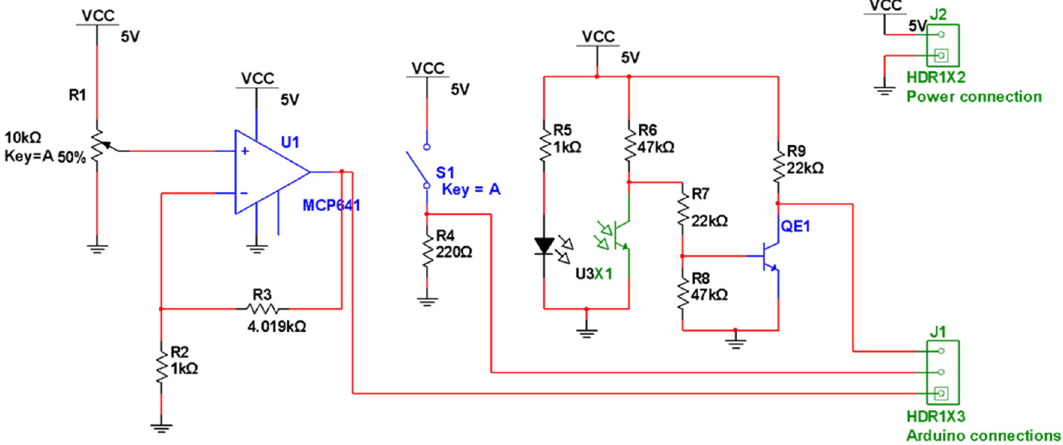
Figure 30. Electrical diagram of the circuit for measuring the thickness of a document with the operating principle of a potentiometer.